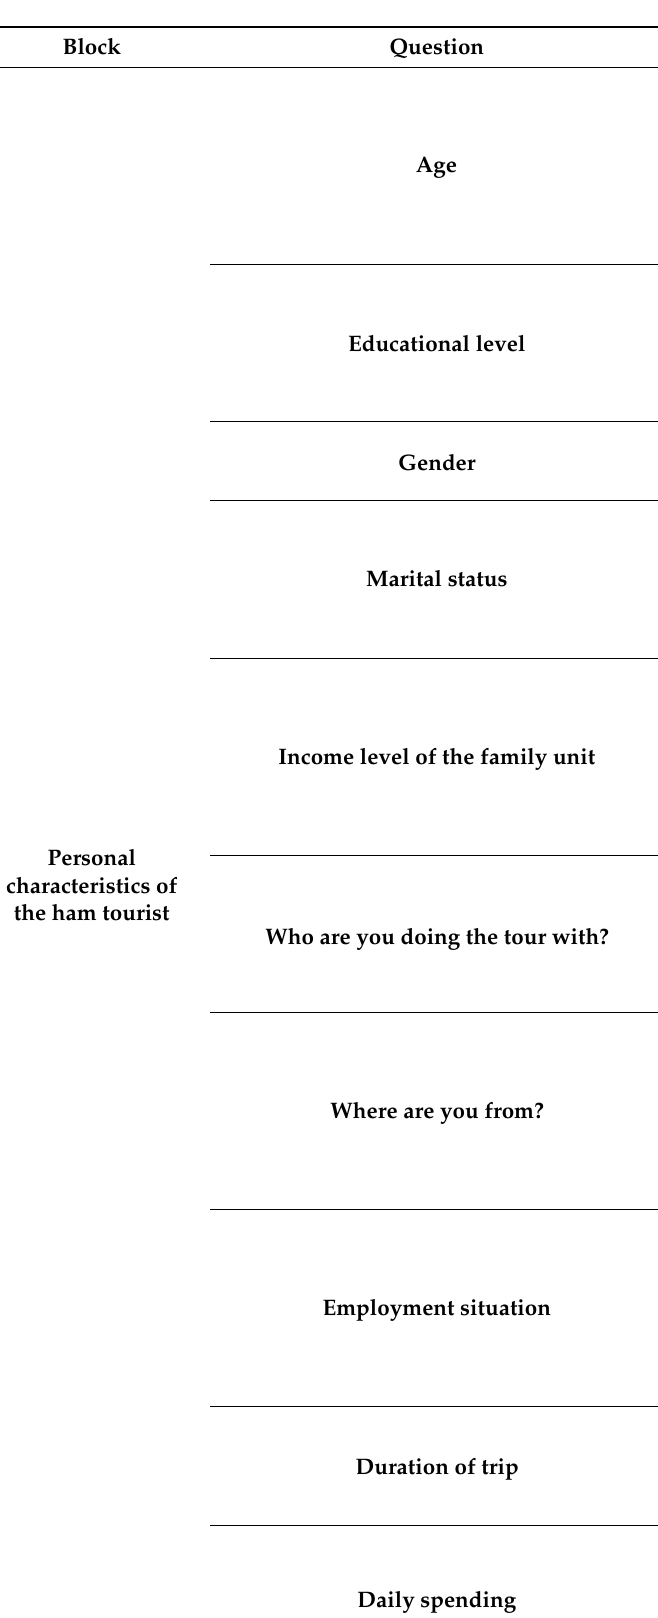
Table 3. Profile of the ham tourist in